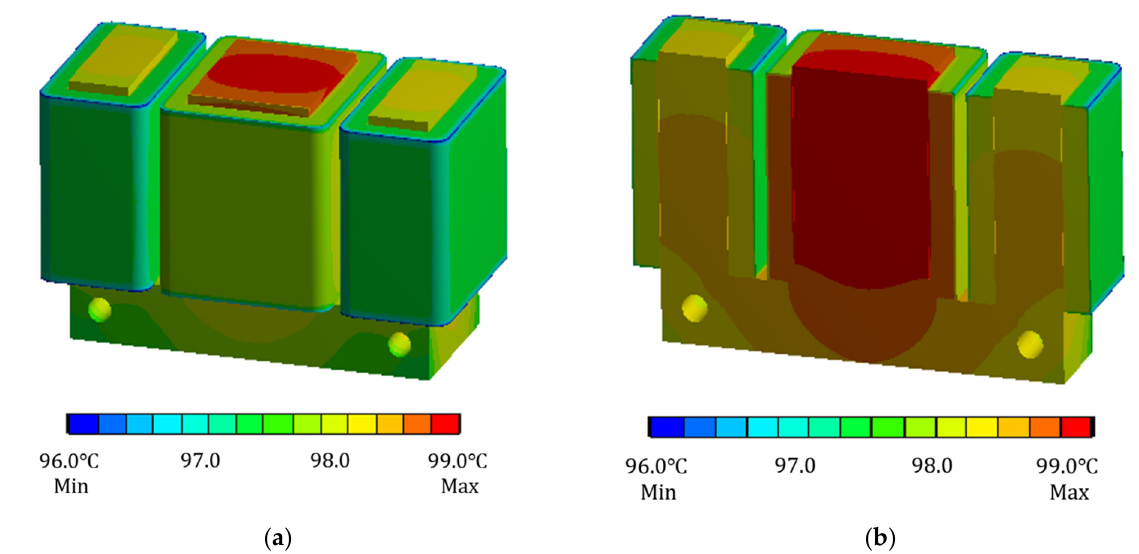
Figure 9. Cloud diagram of steady-state temperature field distribution of electromagnet considering copper loss and iron loss at the same time. ( a ) Overall diagram. ( b ) Cutaway diagram.